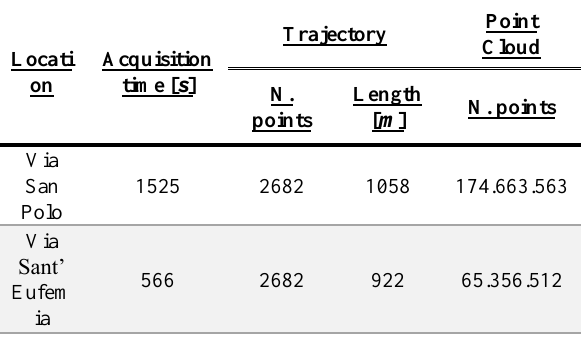
Table 4. Characteristics of the real time solutions of Kaarta